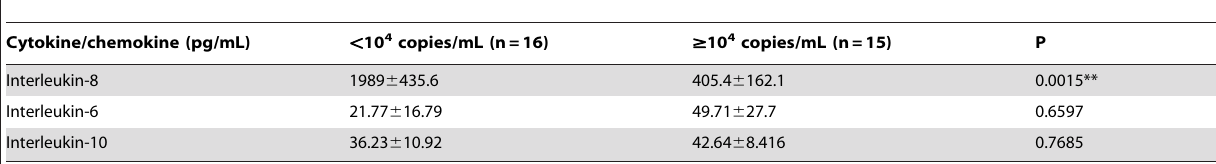
Table 6. Cytokine/chemokine concentrations of respiratory tract aspirates in children with different HBoV viral load.